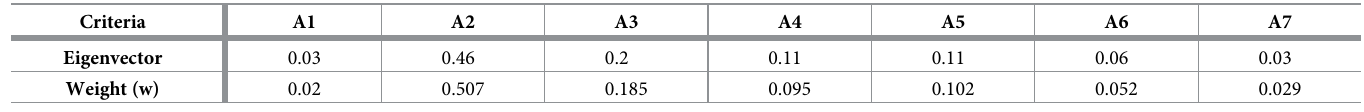
Table 3. Calculation of eigenvalue and criteria weight.